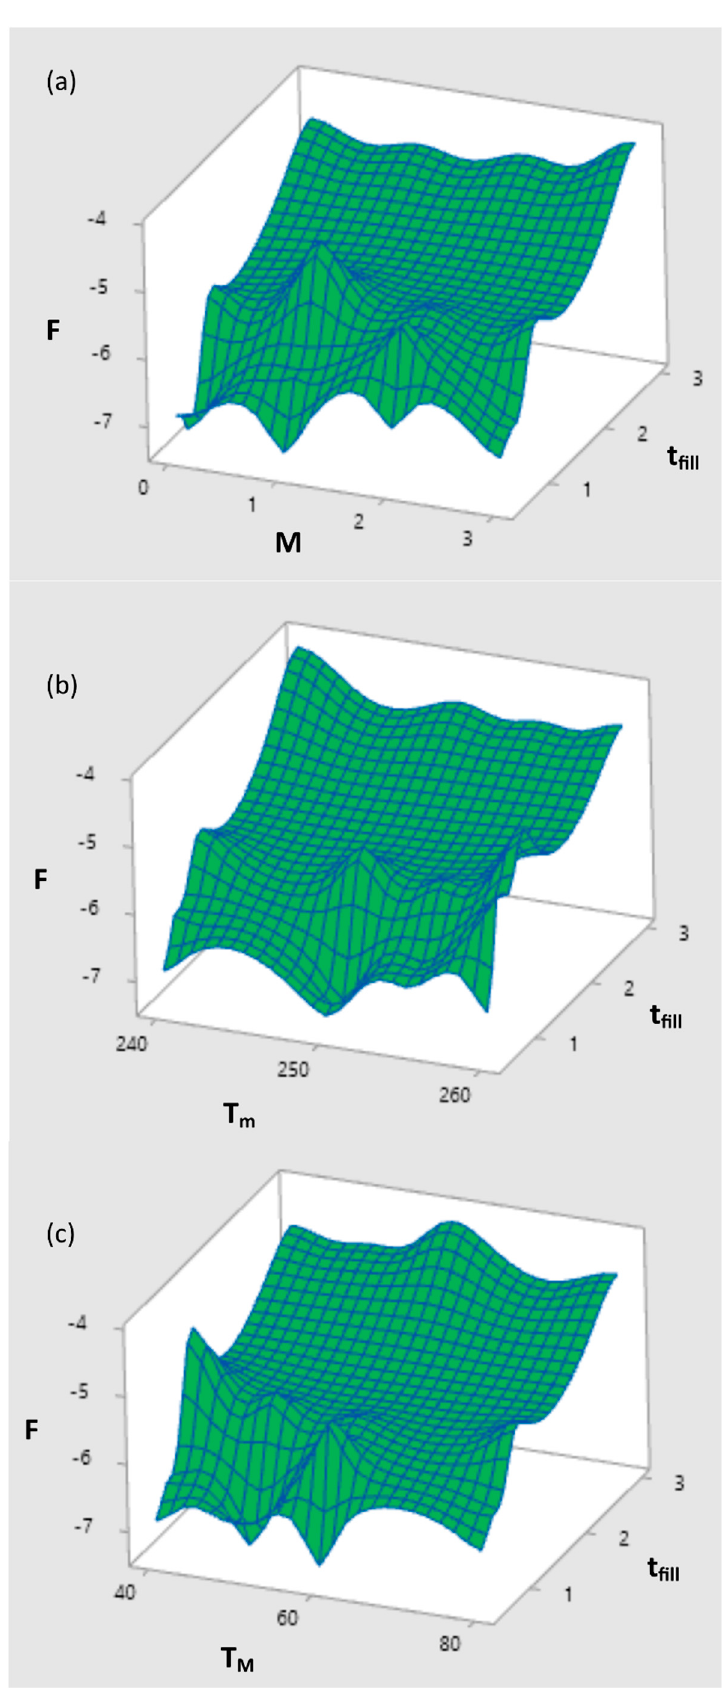
Figure 8. Response surface plot F (global objective function) vs. t fill and ( a ) vs. M for T M = T M opt , T m = T m opt , ( b ) vs. T m for T M = T M opt , G = G opt , ( c ) vs. T M for T m = T m opt , G = G opt .